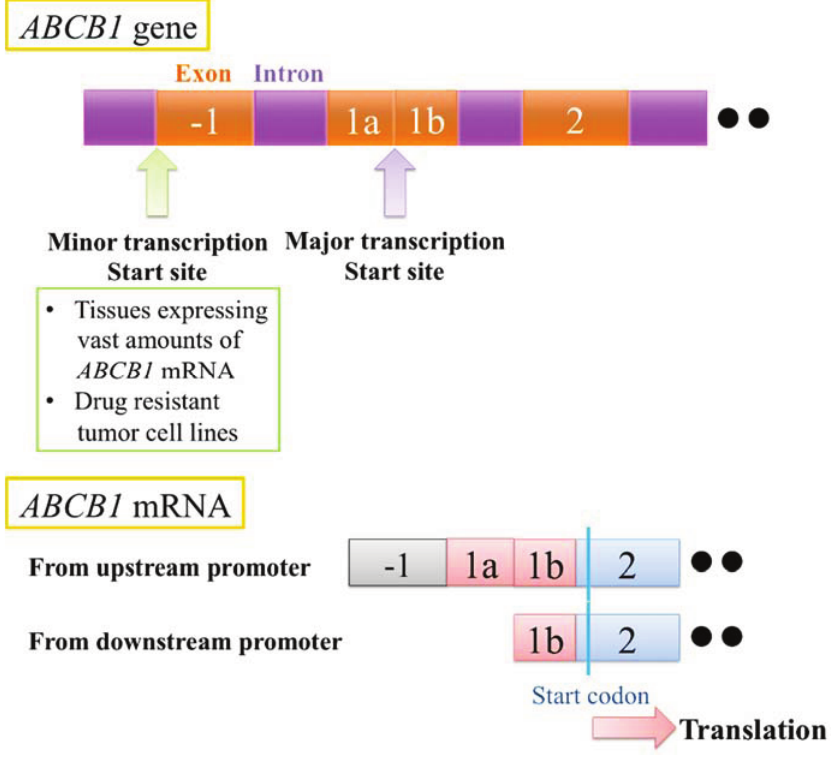
Figure 2. Alternative promoter of human ATP-binding cassette ( ABC)B1